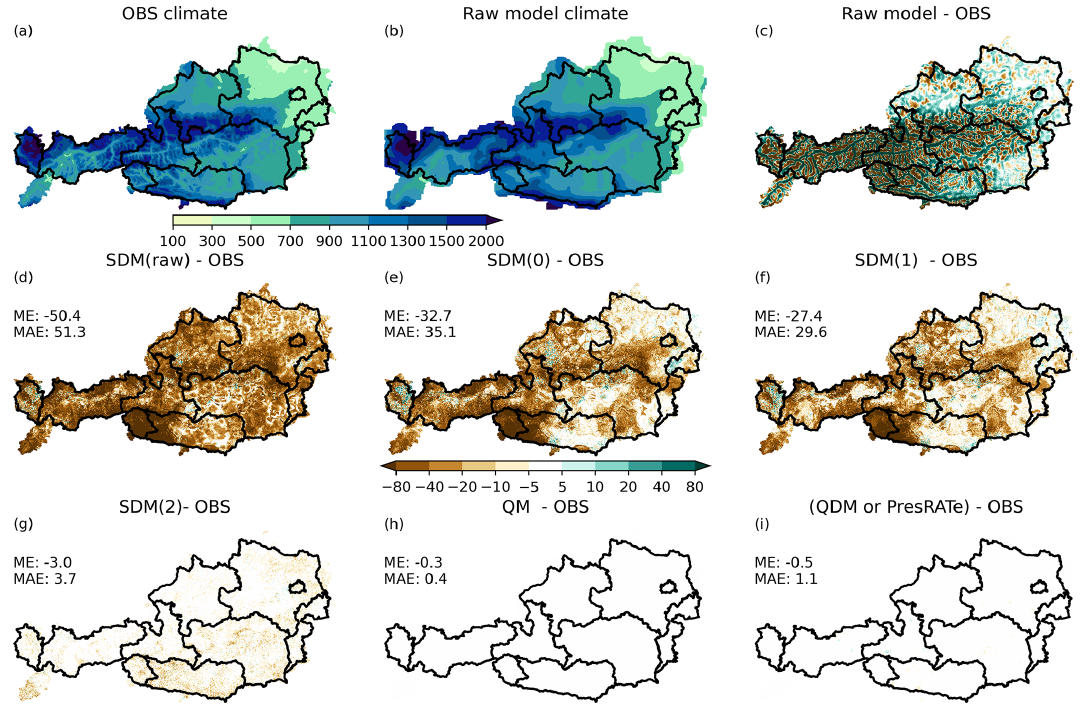
Figure 4. Bias adjustment of precipitation data. The model is produced by smoothing OBS. (a) Observational annual precipitation. (b) Raw model annual precipitation. (c) Difference of annual precipitation between model and observation. (d–i) Difference in annual precipitation (model minus observational data) in millimeters for (d) SDM(raw), (e) SDM(0), (f) SDM(1), (g) SDM(2), (h) QM and (i) QDM/PresRATe. ME – mean error. MAE – mean absolute error.